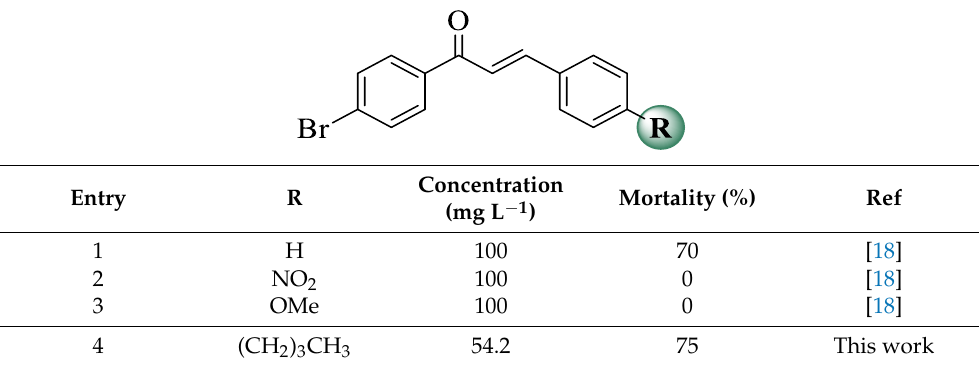
Table 4. Structure–activity relationship of bromochalcone derivatives concerning A. aegypti larvae mortality (%).